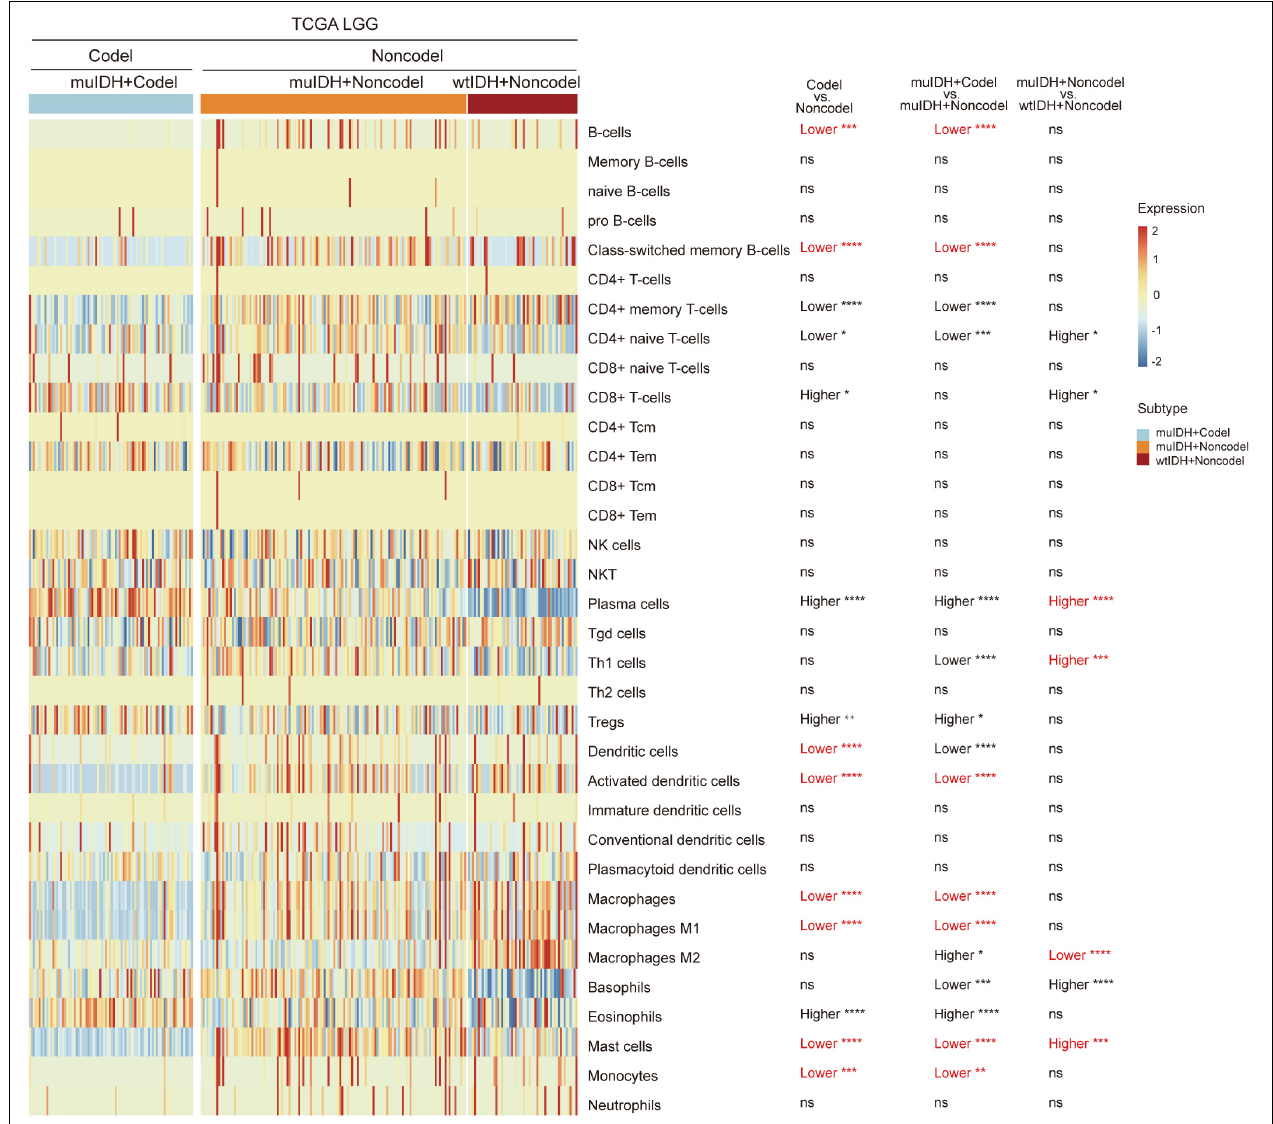
FIGURE 5 | Estimating the infiltrating level of 34 kinds of immune cells in TCGA LGG using xCell tool. The heatmap shows the infiltrating levels of immune cells in different subgroup of LGGs in TCGA LGG. The significant differences confirmed in both CGGA325 and CGGA693 LGG datasets were marked in red. The number of patients in each subgroup was shown in Figure 1 . P values are inferred from a two-sided Student’s t -test or Mann-Whitney test. * p < 0.05, ** p < 0.01, *** p < 0.001, **** p <